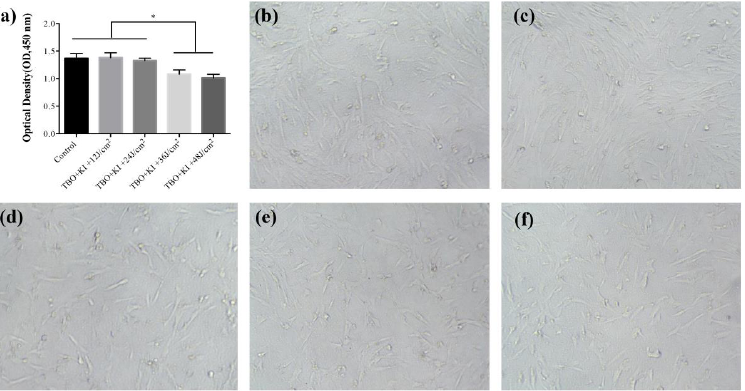
Figure 3. Effect of TBO-mediated aPDT with KI on human dental pulp cells (hDPCs) viability and morphology. HDPCs were incubated with 1 μg/mL TBO and 200 m M KI after shining different doses of red light. ( a ) HDPCs viability in each group determined by cell counting kit-8 (CCK-8) assay. ( b ) Light microscope observation of hDPCs without any treatment, magnification ×100. ( c – f ) Light microscope observation of hDPCs when incubated with 1 μg/mL TBO and 200 m M KI after shining 12, 24, 36, 48 J/cm 2 of red light respectively, magnification × 100. (* p < 0.05 in ANOVA test). 2.4. 1 O 2 Detection and 1 O 2 Quenching Experiment TBO-mediated aPDT could result in singlet oxygen sensor green (SOSG) activation, which indicated that TBO may be more likely to operate via Type II mechanism to gener- ate 1 O 2 (Figure 4a), while the quenching of SOSG fluorescence was observed during the photoactivation of TBO plus KI. Representative time-resolved 1 O 2 luminescence spectrum detected in TBO with or without 200 mM KI is shown in Figure 4b. The observable 1 O 2 lifetime in TBO photoactivation was longer than the sample treated with TBO photoacti- vation plus KI. Figure 4c shows that 1 μg/mL TBO -mediated aPDT could eradicate the microorganisms from plaque suspension in the presence of 200 mM KI. However, when 50 mM L-histidine was added, there was no significant difference in microorganism num- bers when compared to the control group (Figure 4c).